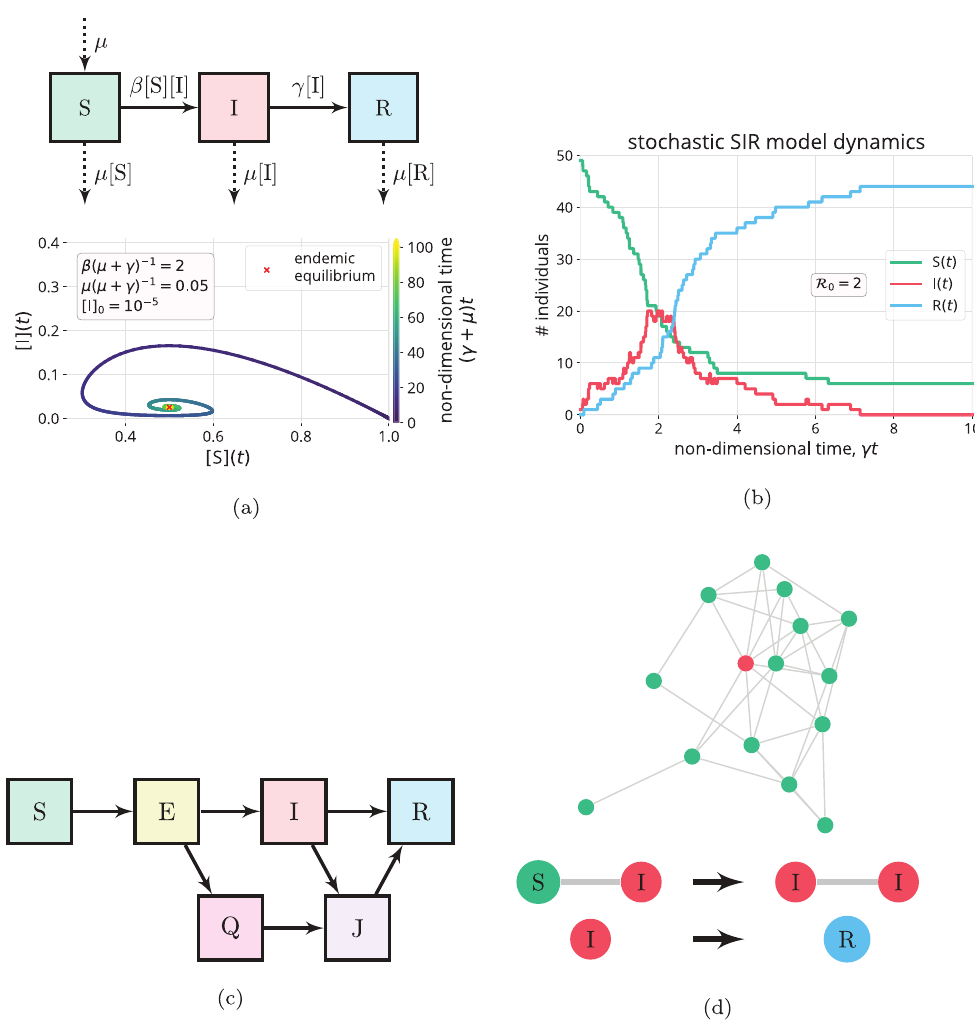
Figure 6 Extensions to the SIR model. (A) Births and natural deaths (balanced, with rate constant µ) are introduced to the SIR model through the fl ows in/out of the compartments denoted by the dashed arrows (top). With births and deaths, the trajectory of the solution in the phase plane (bottom) shows [I]( t ) can exhibit damped oscillations that settle on an endemic equilibrium (µ(µ + γ ) − 1 unrealistically large to clearly see lim t → ∞ [I](t) > 0) ( Hethcote, 2000 ). (B) A simulation of the (stochastic) SIR con- tinuous-time Markov chain model ( Allen, 2017 ) for a small population of 50 individuals, with one initially infectious. The state variables S, I and R are discrete counts of individuals in the compartments. (C) Introducing additional compartments. For example, exposed individuals have been exposed to and infected by the disease, but cannot yet transmit the disease, due to a latent period. Owing to control measures, quarantined (Q) and isolated (J) individuals make contacts with a reduced frequency. (D) Contact network models. (top) Nodes represent individuals, and each is in the S, I, or R state. Edges, along which disease transmission can occur, represent contacts. (bottom) The state changes of nodes in an SIR contact network model ( Kiss, Miller & Simon, 2017